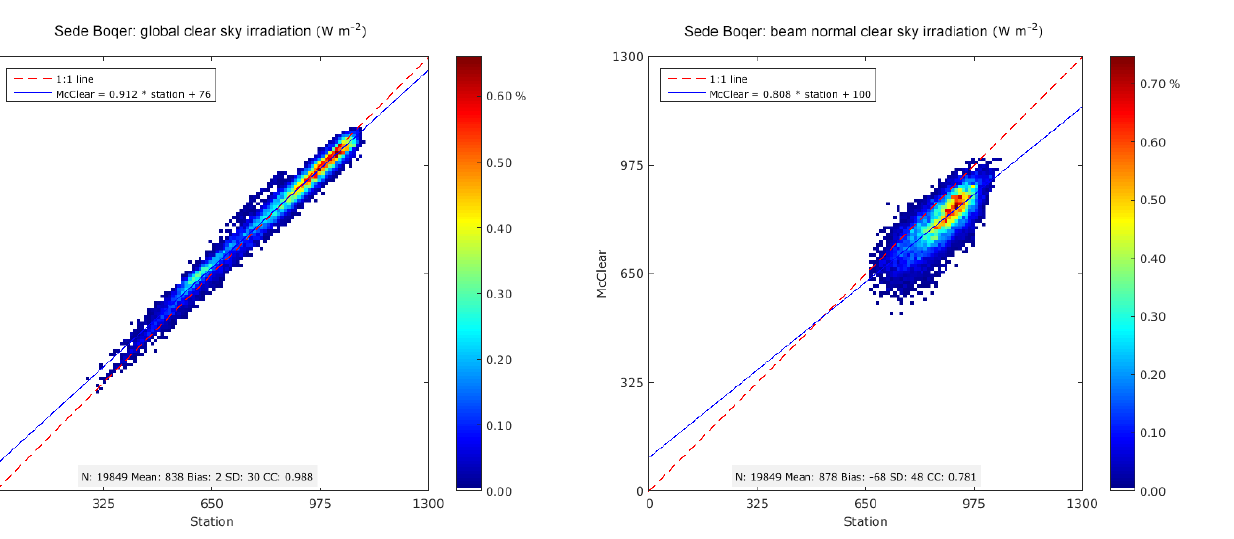
Figure 3. 2-D histogram of measurements (horizontal axis) and McClear estimates (vertical axis) of B N for Sede Boqer. The colour represents the frequency of each